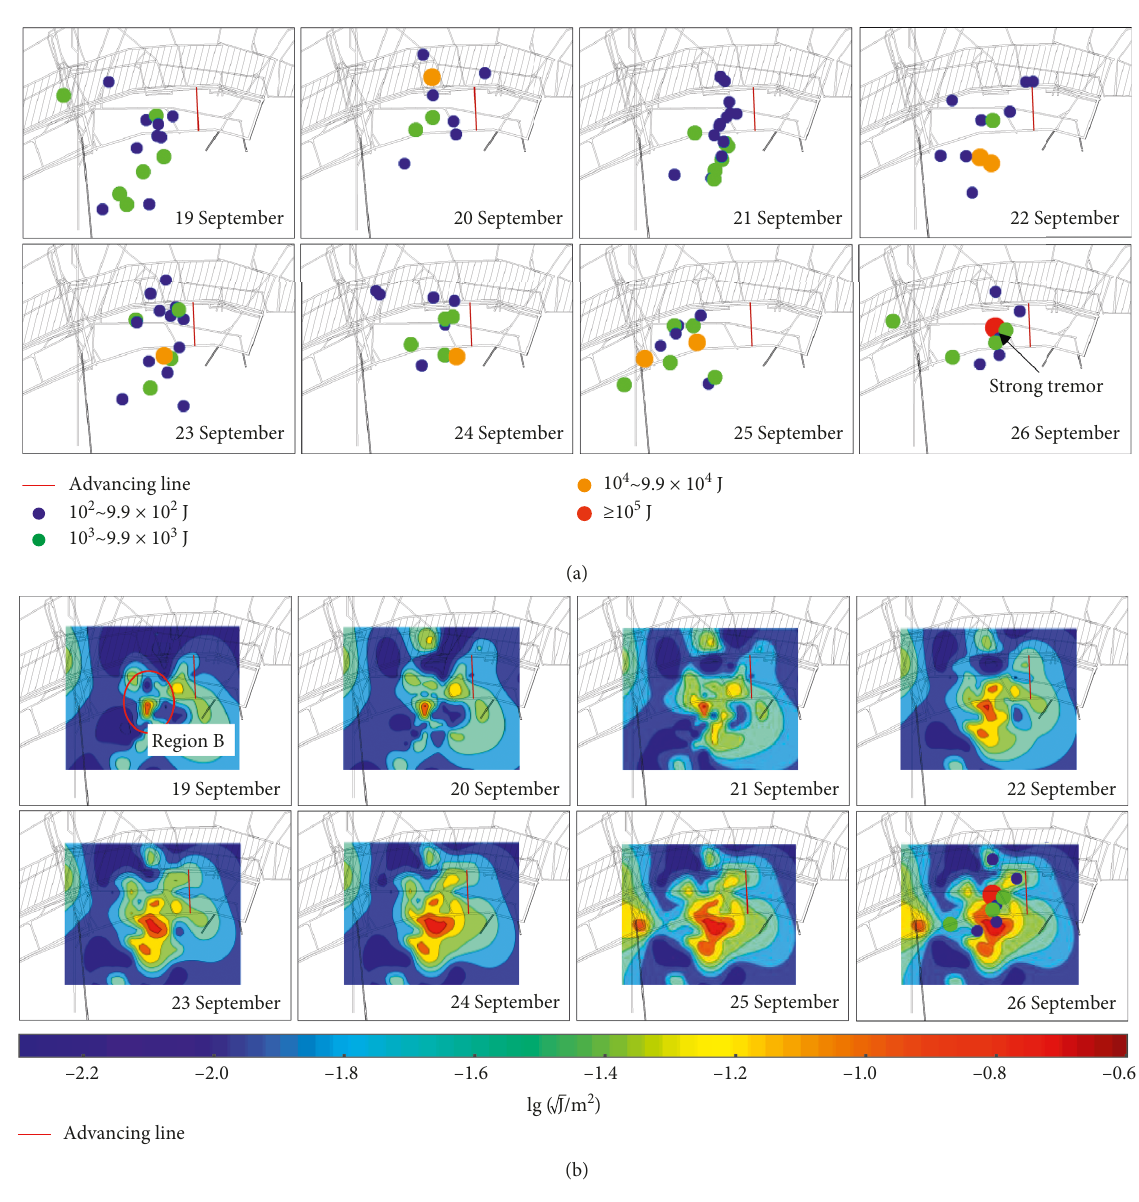
Figure 5: Evolution of spatial tremors (a) and energy density clouds (b) before a strong tremor (19–26 September